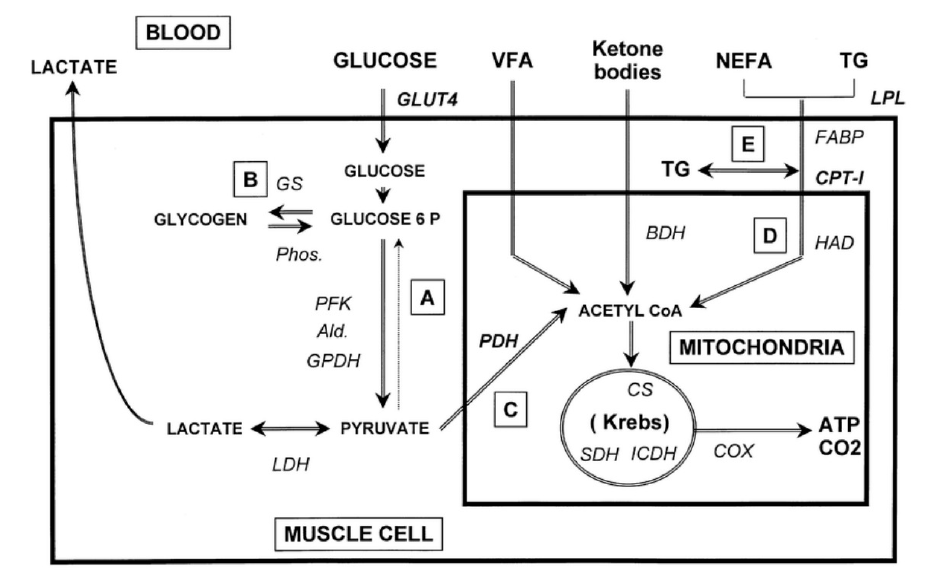
Fig. 1 Energy consumption and substrate metabolism of different sex